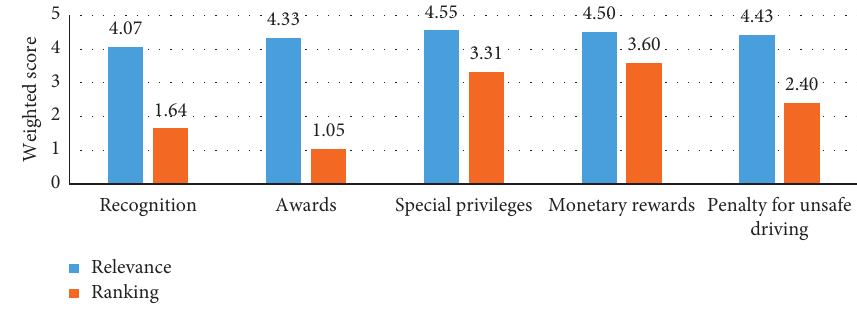
Figure 5: Weighted mean of relevance and priority ranking related to Question A4.